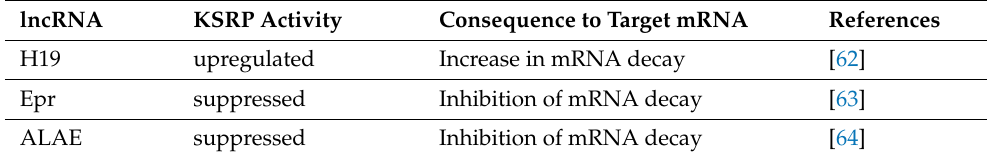
Table 5. lncRNAs interacting with